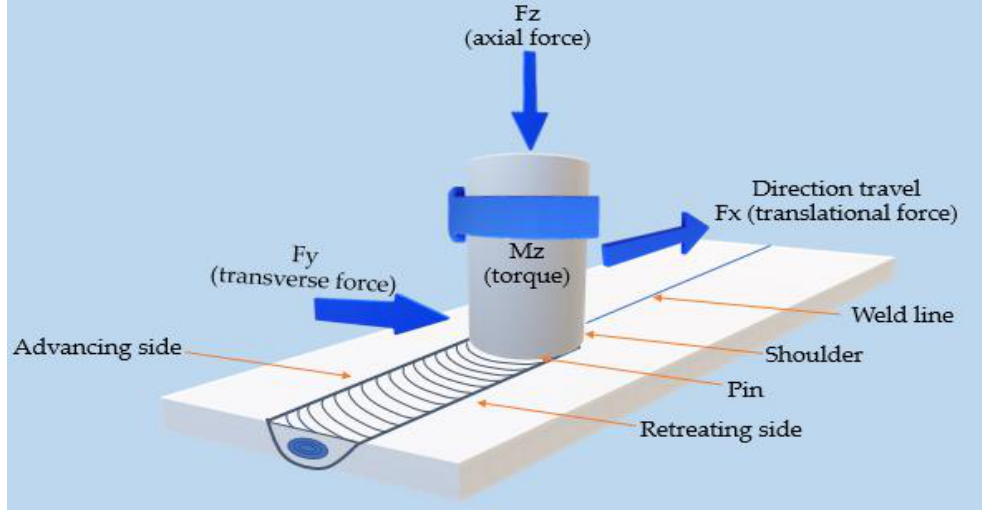
Figure 2. Friction stir welding process.